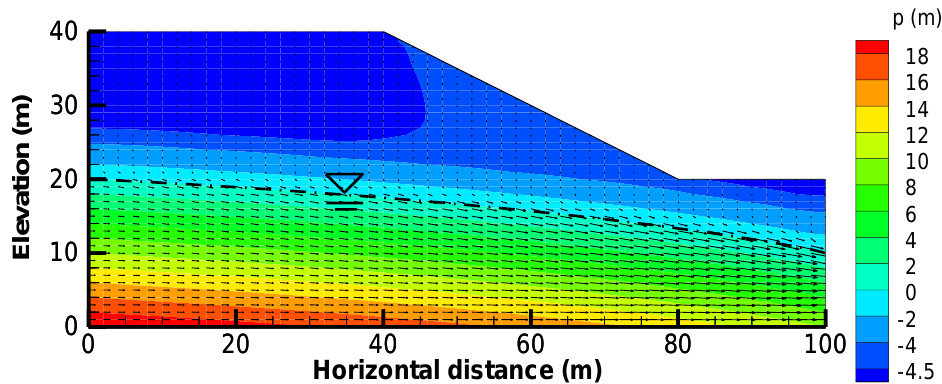
Figure 3. Results of deterministic seepage analysis.